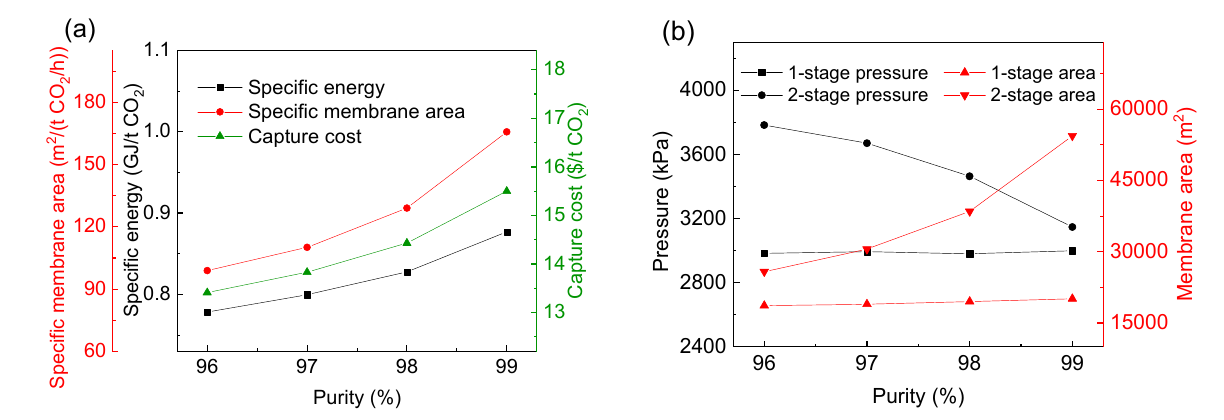
Figure 9. Effect of increasing CO 2 purity on the optimal process using the commercial membrane in Table 2. ( a ) CO 2 capture cost, specific power consumption and membrane area; ( b ) optimal inlet pressure and area of each stage membrane.